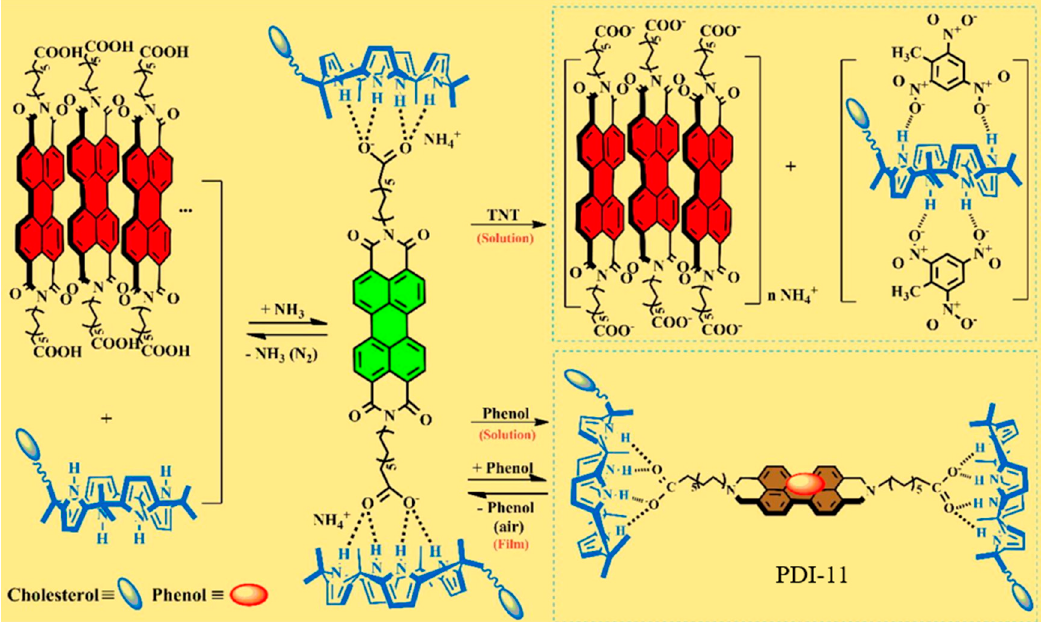
Figure 12. Schematic representation of the assembly and disassembly of a fluorescent supramolecular ensemble of calix[4]pyrrole with PDI-11, and its interaction with TNT and phenol in two different modes leading to turn-on of PDI aggregate fluorescence and quenching of fluorescence of PDI molecules. Note: the former is irreversible, but the latter could be recovered by purging of N 2 or air [76].